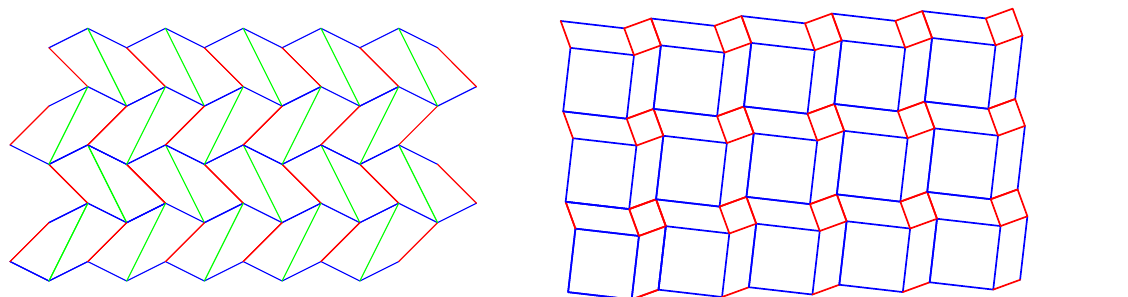
Fig. 35: A pair of opposite edges are equal and all tiles are equal. Fig. 36: Tiling with two different squares and equal parallelograms